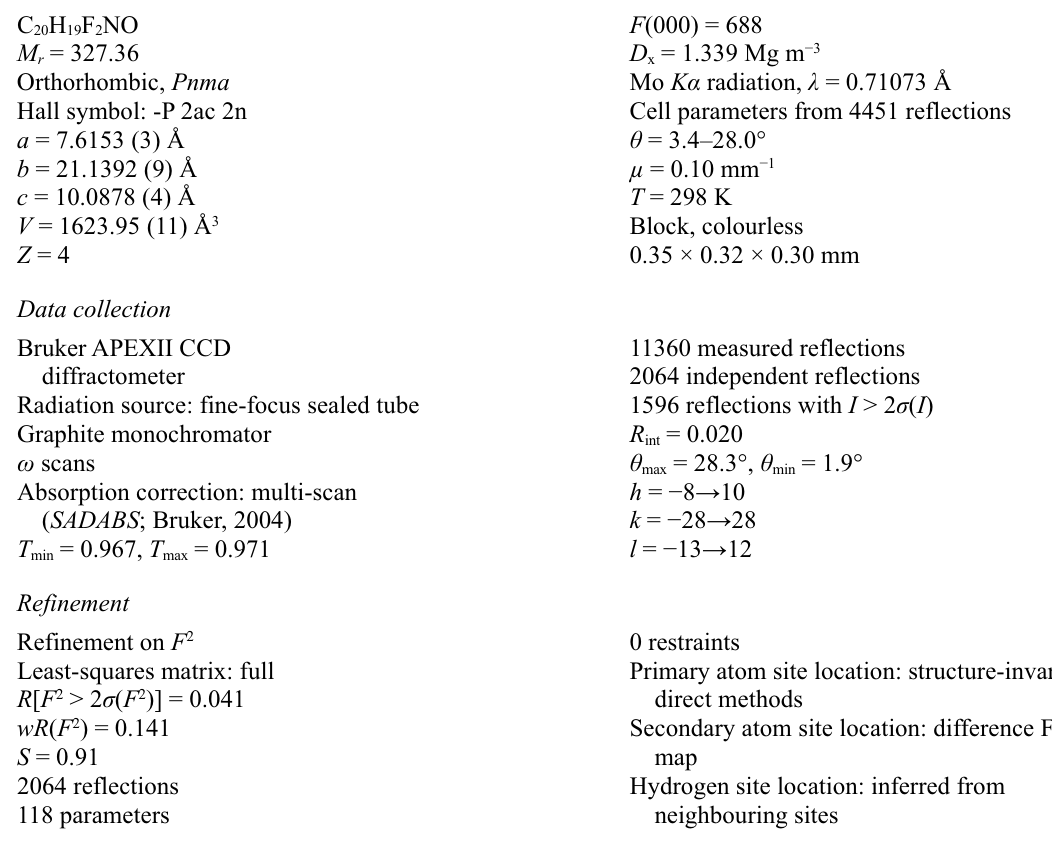
Figure 1 The molecular structure of (I) with non-hydrogen atoms represented as 30% probability ellipsoids. 2,4-Bis(4-fluorophenyl)-3-azabicyclo[3.3.1]nonan-9-one Crystal